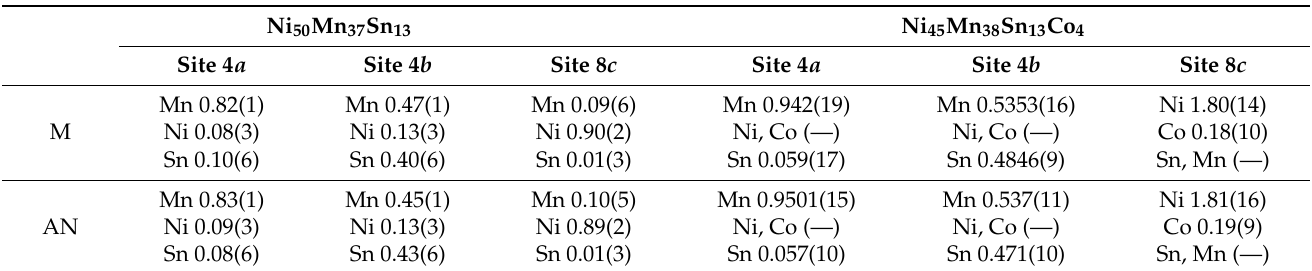
Figure 1. Neutron Diffraction pattern for the milled and annealed Sn13 and Sn13Co samples. The measurements were taken at 420 and 300 K, respectively, to study the long-range atomic order of the austenite phase ( Fm ¯3 m ). The diffraction data corroborates the lack of atomic disorder for the milled as well as for the annealed samples. Table 1. Occupancies for 4 a ( 0,0,0 ) , 4 b ( 1/2,1/2,1/2 ) and 8 c ( 1/4,1/4,1/4 ) positions of the milled and annealed Ni 50 Mn 37 Sn 13 and Ni 45 Mn 38 Sn 13 Co 4 samples obtained from the Rietveld refinement at 420 K and 300 K, respectively. The obtained values indicate the same atomic structure in the milled and annealed sample of each